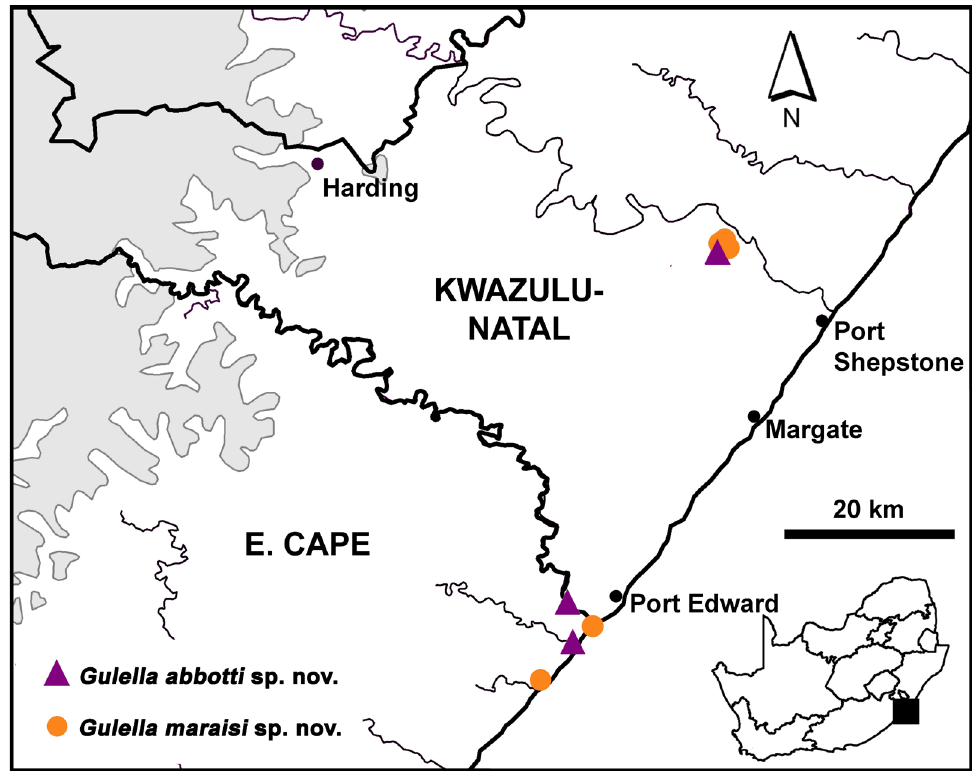
Fig. 10. Distribution map of Gulella abbotti sp. nov. (purple triangles) and G. maraisi sp. nov. (orange circles). Contour at 1000